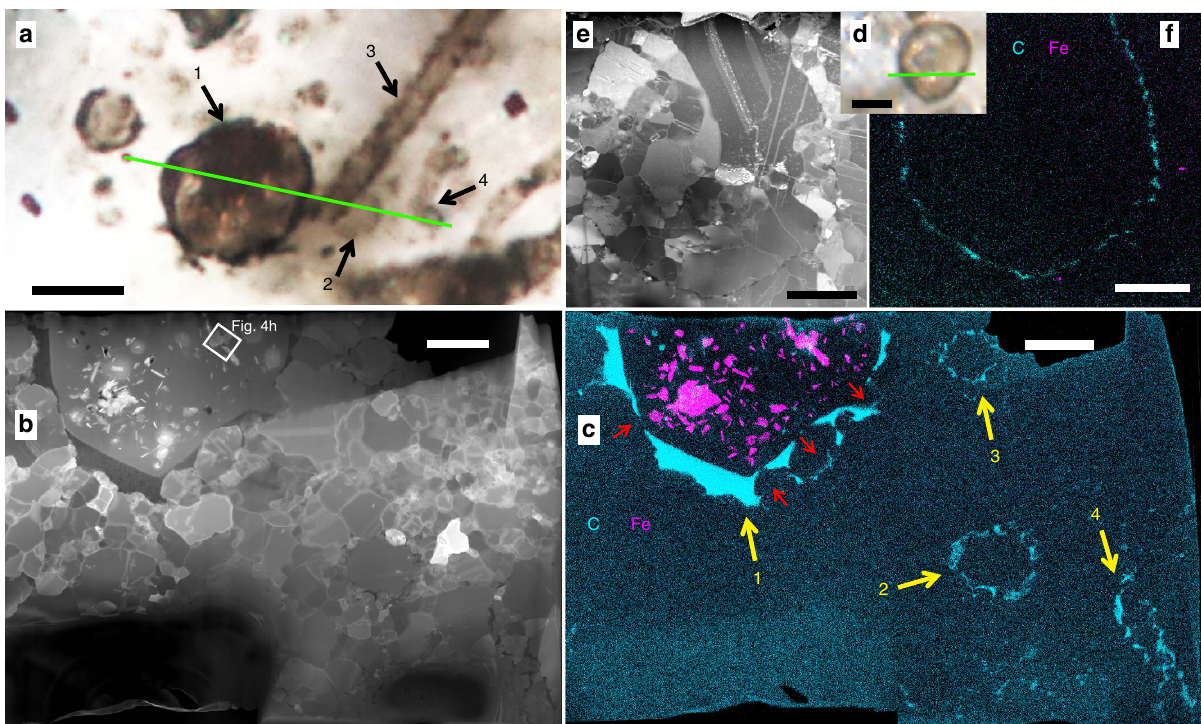
Figure 1 | Iron in Gunflint microfossils. ( a – c ) 1: thick-walled Huroniospora , 2: thin-walled Huroniospora , 3–4: Type 1 (cell-free sheaths) G. minuta . ( d – f ) Thin- walled Huroniospora . ( a , d ) Multiplane photomicrographs. Scale bars, 5 m m. ( b , e ) STEM dark-field images of the FIB ultrathin sections cut along the green lines. Scale bars, 2 m m. ( c , f ) STEM maps of Fe (pink), C (cyan); corresponding maps of Si, O and S are shown in Supplementary Fig. 4. Scale bars, 2 m m. Fe minerals are highly concentrated inside thick-walled Huroniospora and nearly absent in or near Type 1 G. minuta and thin-walled Huroniospora . Red arrows in c indicate displacement of wall organic matter by quartz